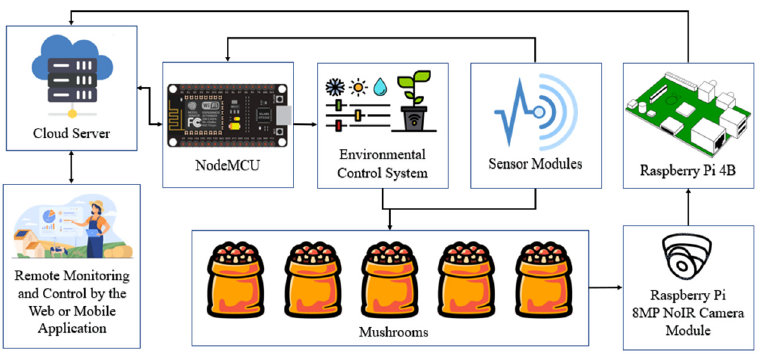
Figure 2. The overall block diagram for the IoT based environmental control and monitoring system.